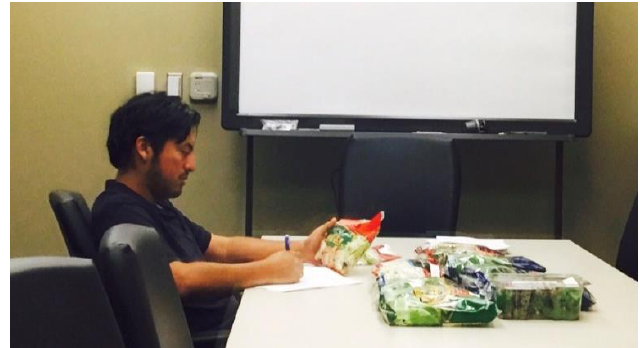
Figure 1. A consumer performing the modified individual sample description technique [20] with RTE salads.